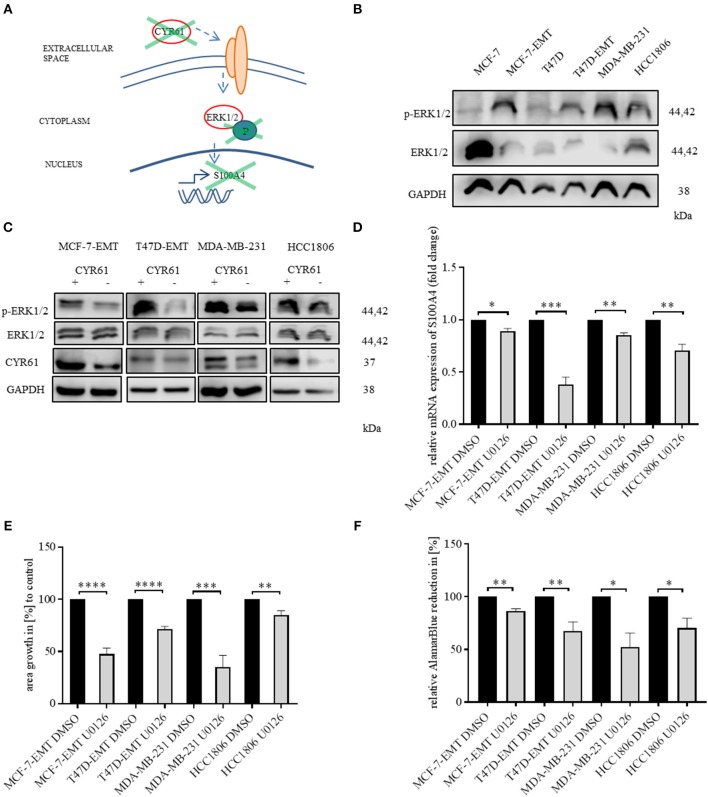
ERK1/2 activity is transducer of CYR61 mediated S100A4 regulation. (A) Scheme illustrating hypothesis of CYR61 regulating S100A4 in a p-ERK1/2 dependent manner. (B) ERK1/2 and p-Erk1/2 (Thr202/Tyr204) expression in different breast cancer cell lines detected by western blotting. (C) ERK1/2 and p-Erk1/2 (Thr202/Tyr204) and CYR61 expression in different breast cancer cell lines after transient CYR61 transfection detected by western blotting. (D) Relative S100A4 expression of invasive breast cancer cell lines treated with 10 μM U0126 compared to DMSO controls. Data represent mean ± SEM. Using unpaired, two-tailed t-test analysis. n = 3; *P < 0.05;
**P < 0.01;
***P < 0.005 (E) 3D invasion analysis of breast cancer spheroids seeded after U0126 treatment. Spheroid area was assessed 48 h after adding Matrigel using polygonal selection and compared to spheroid area at time point 0 (adding of Matrigel + 10 μM U0126). Area growth was compared to area growth of control spheroids. Data represent mean ± SEM. Using unpaired, two-tailed t-test analysis. MCF-7-EMT n = 6; T47D-EMT n = 5; MDA-MB-231 n = 6; HCC1806 n = 5; **P < 0.01;
***P < 0.005;
****P < 0.0001 (F) Analysis of relative AlamarBlue reduction as indicator for cell viability. Breast cancer cell spheroids were grown and AlamarBlue reduction was assessed 48 h after adding Matrigel and 10 μM U0126 at 4 h incubation. Relative AlamarBlue reduction was calculated compared to DMSO control spheroids. Data represent mean ± SEM. MCF-7-EMT n = 3; T47D-EMT n = 4; MDA-MB-231 n = 3; HCC1806 n = 3; *P < 0.05;
**P < 0.01.